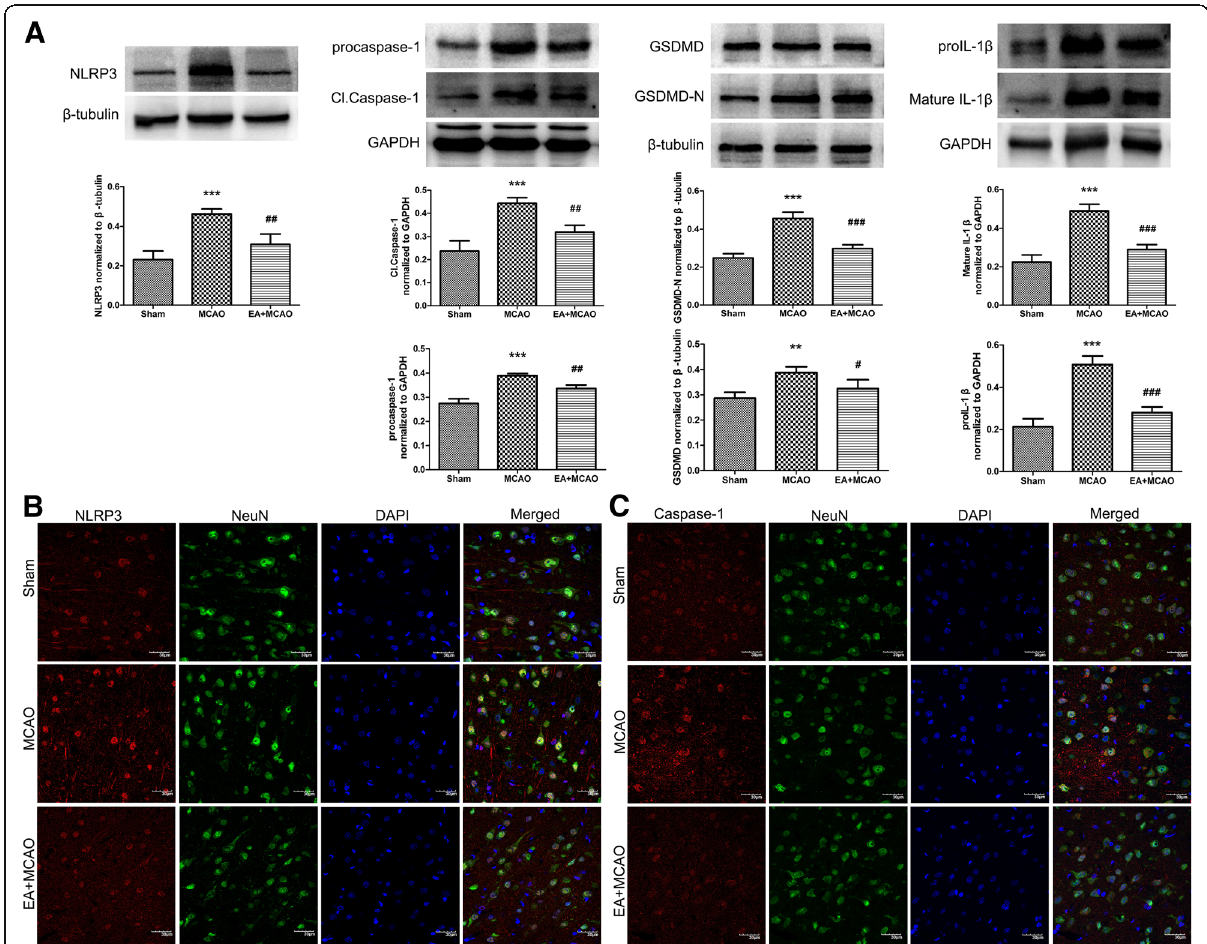
Fig. 3 Effect of EA stimulus on the expression of NLRP3 inflammasome. a Representative western immunoblotting analysis of NLRP3, Caspase-1 and IL-1 β ( n =4). EA stimulus significantly decreased the levels of NLRP3, procaspase-1, Cl.Caspase-1, GSDMD, GSDMD-N, proIL-1 β and mature IL-1 β when compared with MCAO group. ** P <0.01, *** P <0.001 vs. Sham group, ## P <0.01, ### P <0.001 vs. MCAO group. ( b , c ) Immunofluorescent staining of NLRP3, Caspase-1, neuronal nuclei (NeuN), and nuclear marker DAPI. EA stimulus decreased the levels of NLRP3 positive neurons and Caspase-1 positive neurons when compared with MCAO group. Scale bar=30 μ